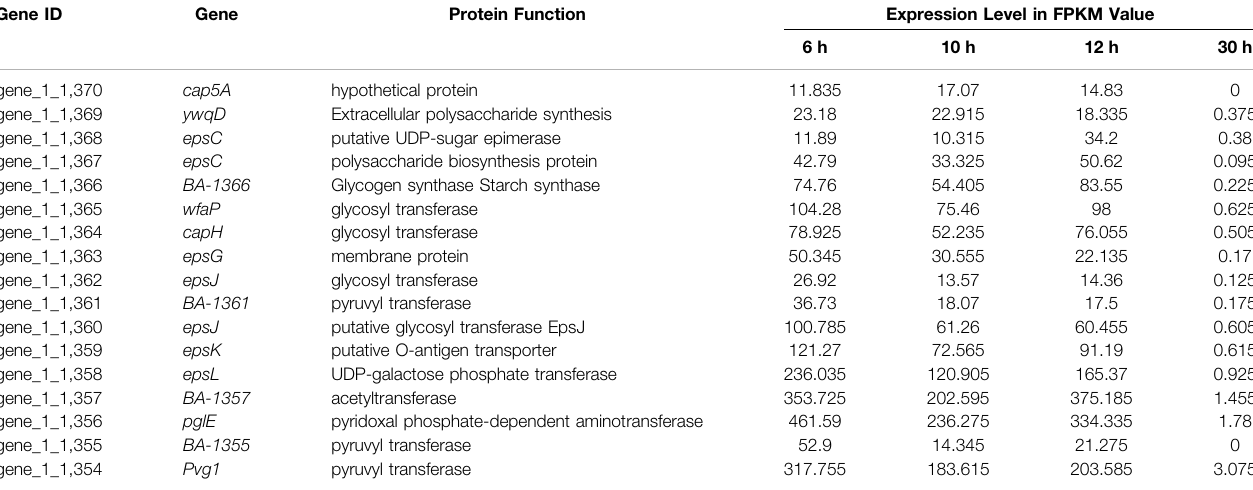
TABLE 4 | Relative expression level of genes related to the extracellular polysaccharides of B. amyloliquefaciens TCCC11018 during the entirety of each growth phase. Gene ID Gene Protein